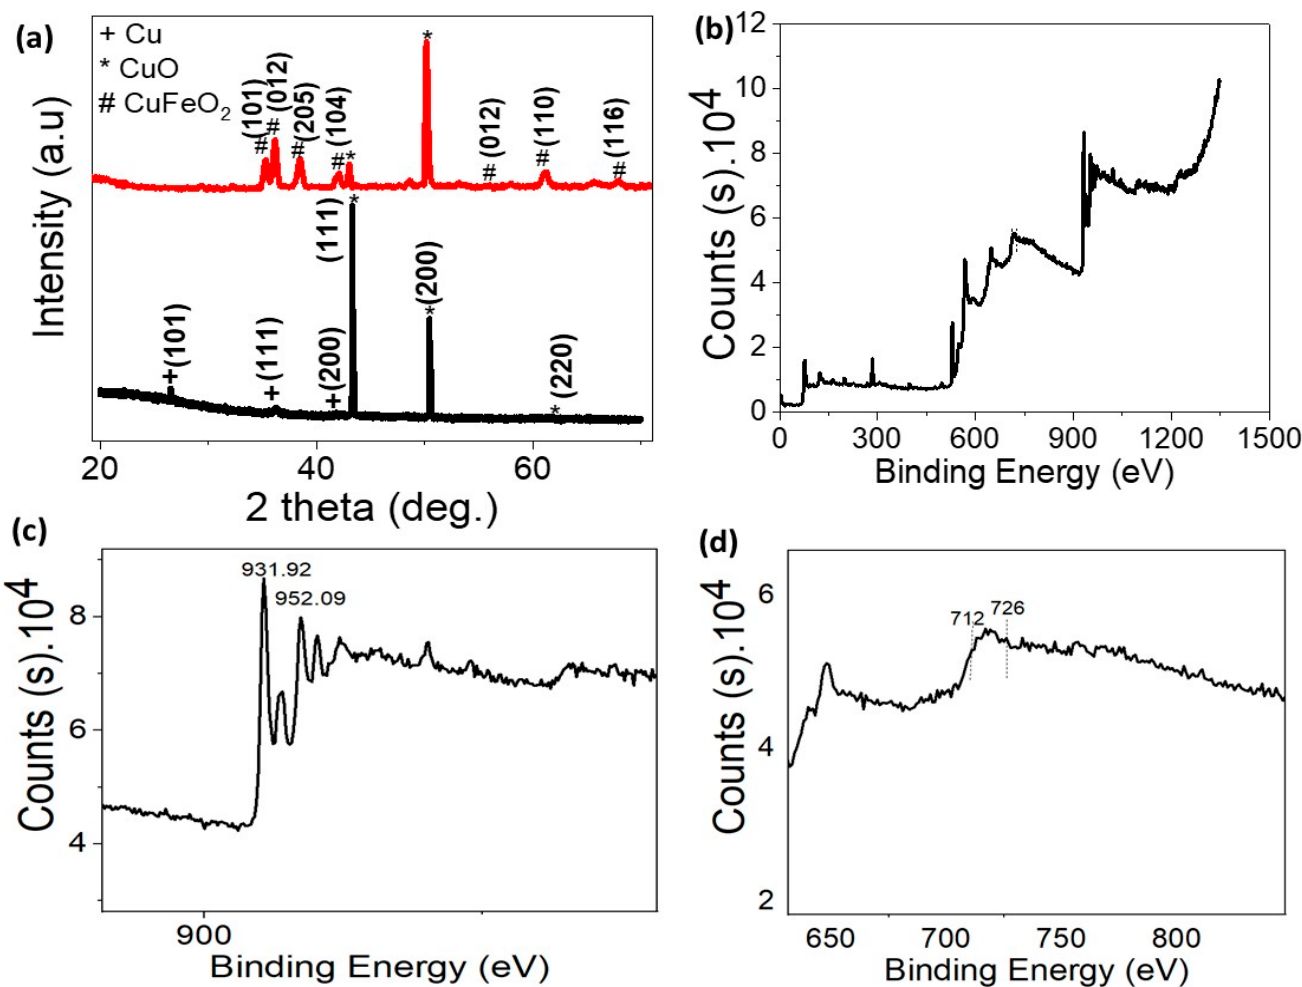
Figure 2. ( a ) The XRD of CuFeO 2 , ( b ) XPS of CuFeO 2 , ( c ) Cu 2P, and ( d ) Fe